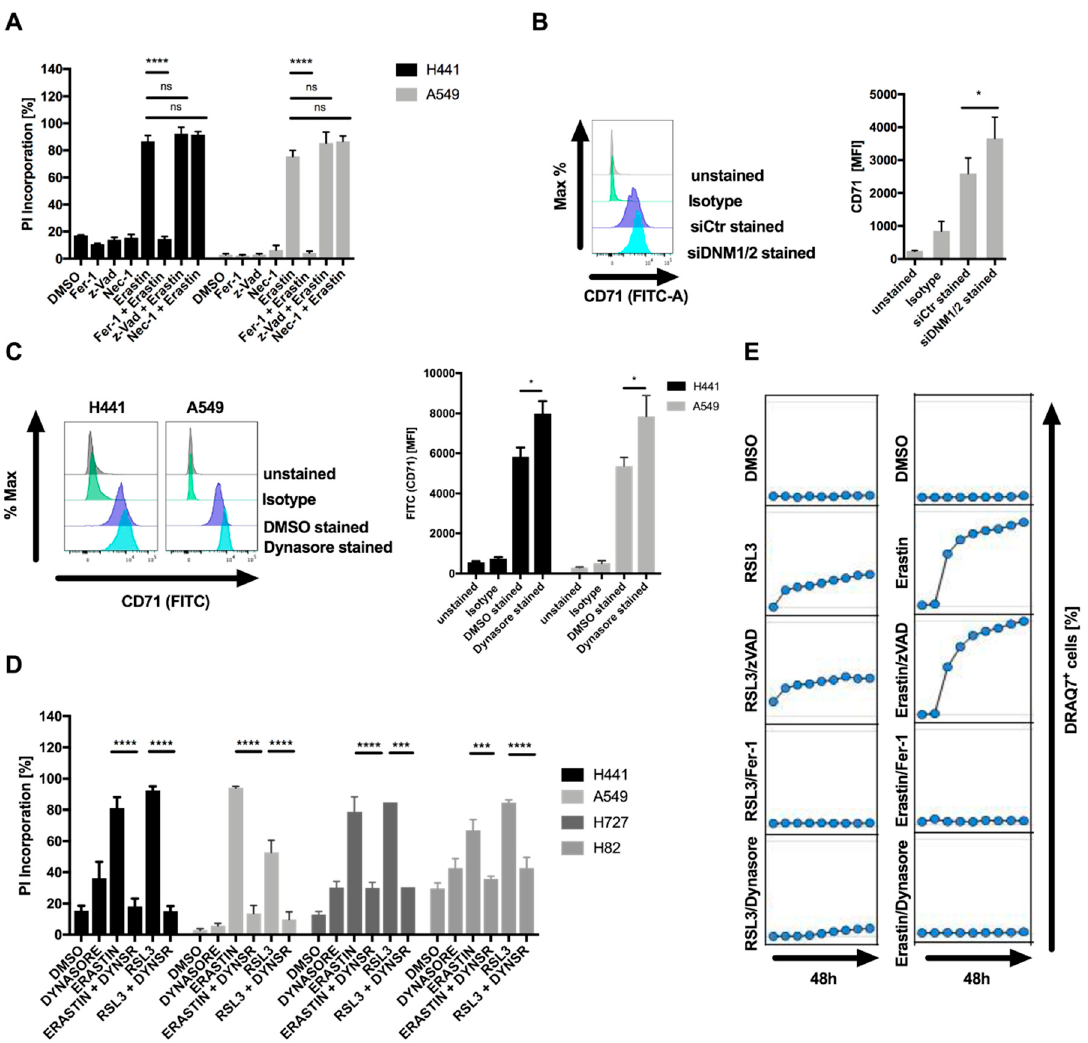
Figure 1. Dynasore inhibits ferroptosis. ( A ) The indicated cell lines were treated with DMSO, ferrostatin-1 (5 µ M), erastin (10 µ M), zVAD (20 µ M), Nec-1 (20 µ M) or the indicated combinations for 48 h. Cell death was quantified by propidium iodide (PI) uptake and flow cytometry. ( B ) H441 cells were transfected with control or dynamin 1 and 2 (DNM1-2)-targeting small interfering RNA (siRNA) for 48 h. Surface expression of CD71 was determined by staining and flow cytometry. ( C ) The indicated cells were treated with dynasore for 48 h. Surface expression of CD71 was quantified as in B. ( D ) Cells as indicated were treated and quantified as in A, but replacing ferrostatin-1 by dynasore (80 µ M). ( E ) A549 cells were treated with DMSO, ferrostatin-1 (5 µ M), erastin (10 µ M), zVAD (20 µ M), dynasore (80 µ M) or the indicated combinations. Images were acquired every 8 h for 48 h. Dead cells were quantified as % DRAQ7 + cells using the IncuCyte image analysis software. All data are means +/ − standard error of the mean (SEM) of at least three independent experiments, or representative images where applicable. MFI—mean fluorescence intensity. * indicates p < 0.05; ** indicates p < 0.01; *** indicates p < 0.001; **** indicates p < 0.0001; ns indicates non-significant differences.